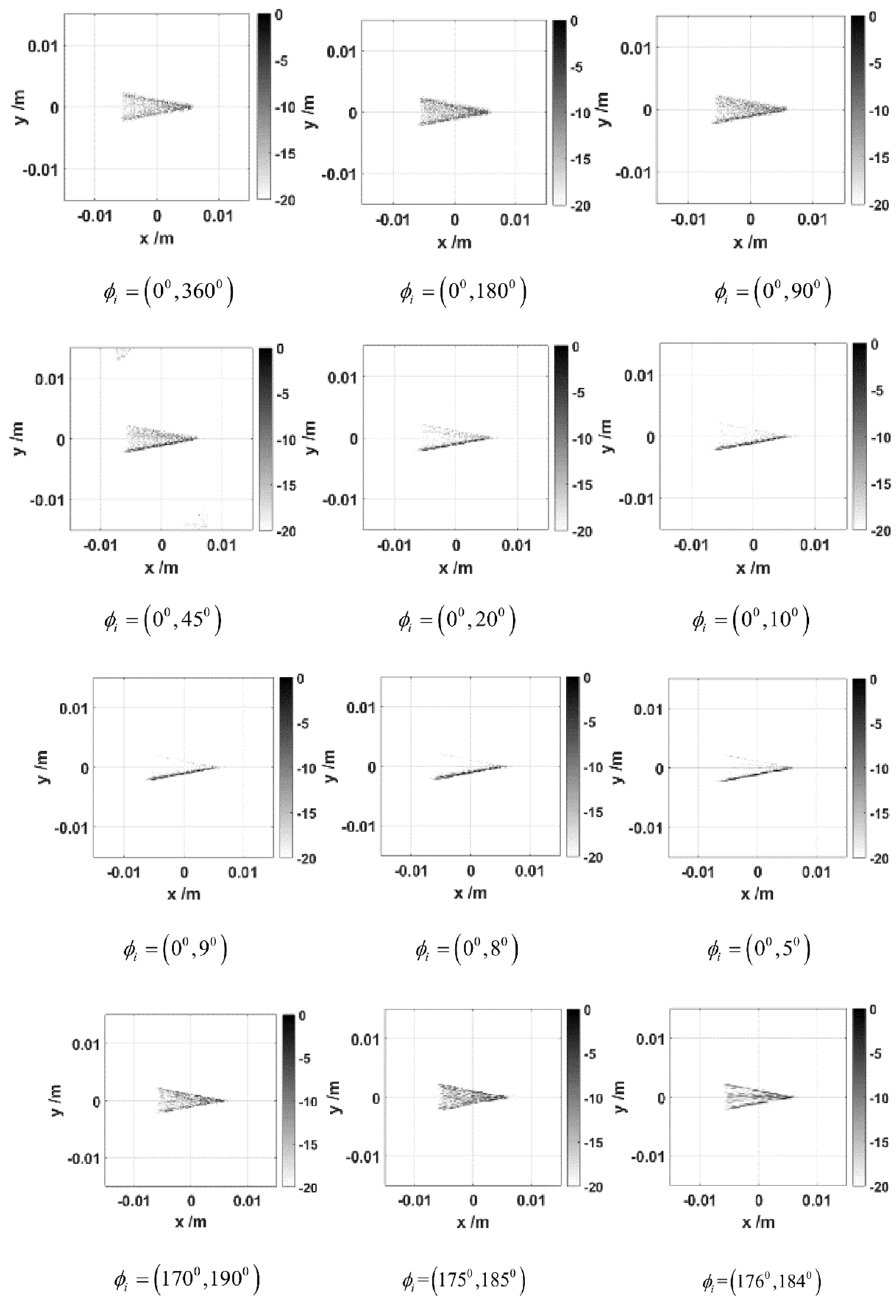
Figure 3. The effect of rotation angle on rough cone ISAL imaging. On the basis of the ISAL imaging of rough square plate, rough circular plate, and rough cone, under the same conditions, the ISAL imaging time of the rough square plate, rough circular plate, and rough cone was observed under different rotation azimuth angles.